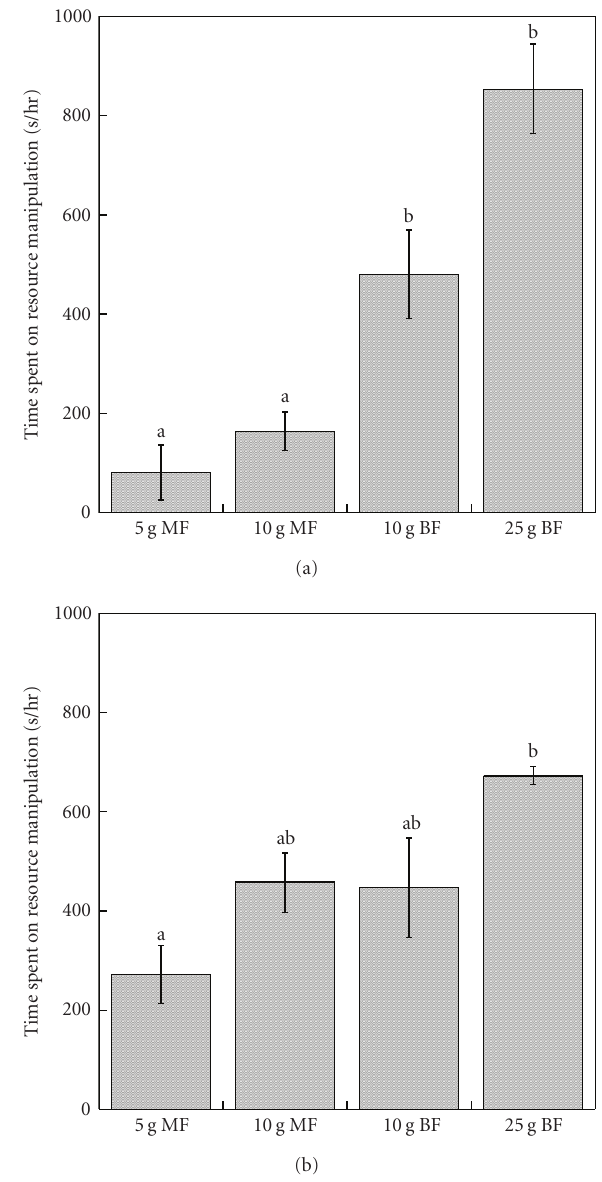
Figure 2: Time spent on resource manipulation by males (a) and females (b). Bars show SE. Di ff erent letters indicate a significant di ff erence (Steel-Dwass test: P < . 05). MF: Maternal feeding, BF: Biparental